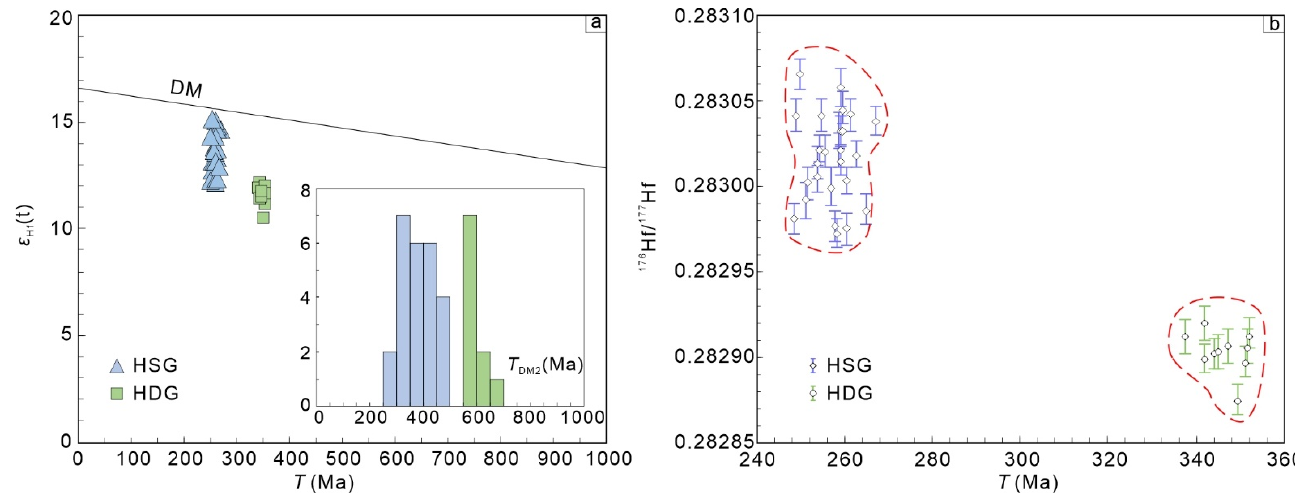
Figure 6. ( a ) In situ zircon Hf isotope diagram. ( b ) The initial 176 Hf/ 177 Hf ratios from HSG and HDG.